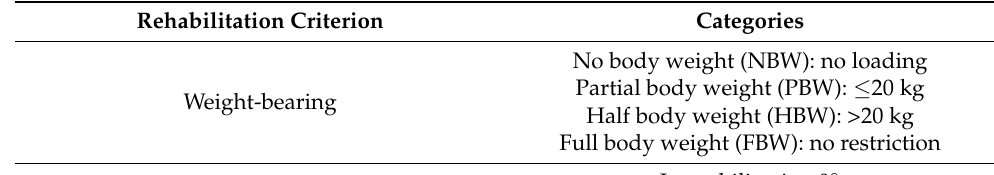
Table 1. Categories of early